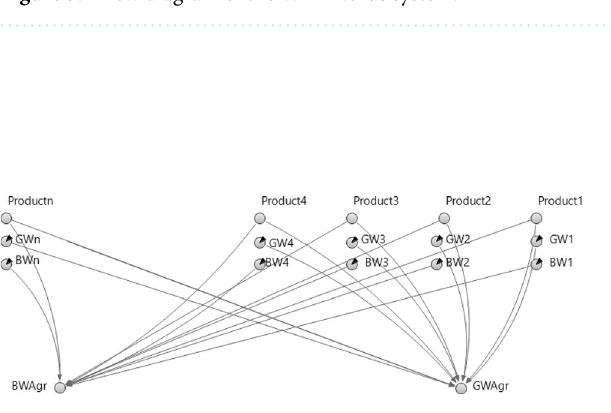
Figure 3. Flow diagram of the WFE Nexus system.